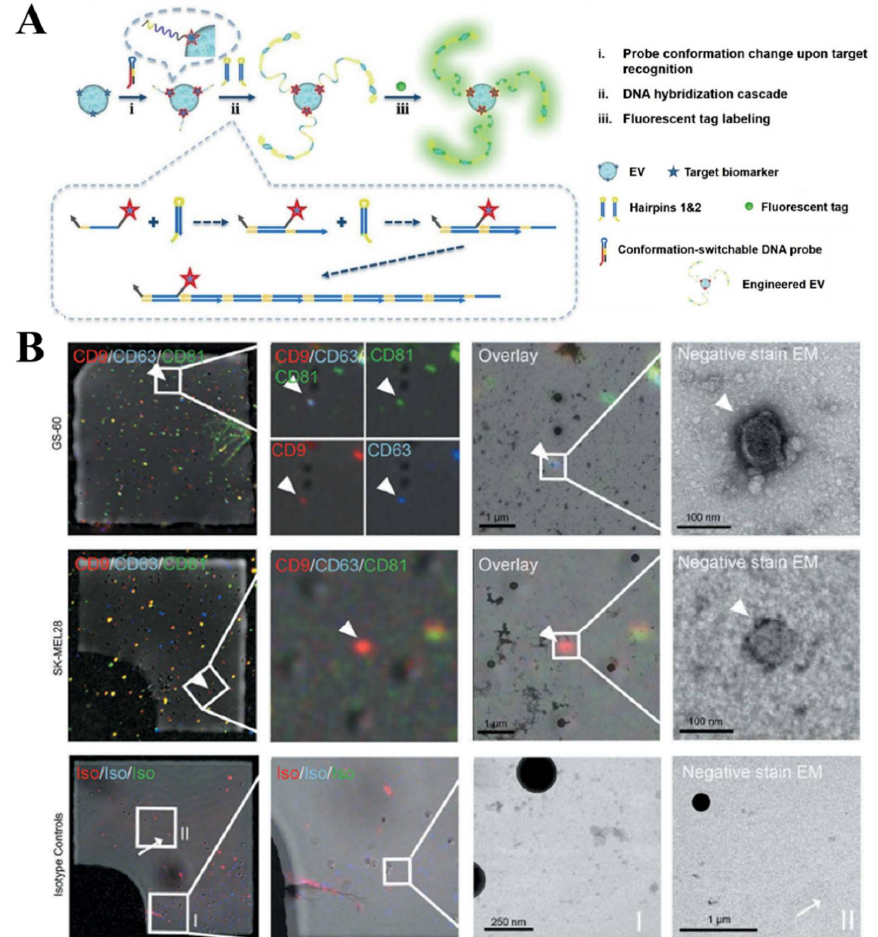
Figure 5. Flow cytometry-based techniques for the single EV molecular analysis. ( A ) Single EV anal- ysis using FCA, achieved by the target-initiated engineering of the DNA nanostructures. Reprinted with permission from [32]. Copyright 2018, Wiley-VCH Verlag GmbH & Co. KGaA, Weinheim. ( B ) Representative IFCM for the tetraspanin profiles on different EVs. White arrowheads indicate fluo- rescence positive single EVs and mark an example of a triple positive EV (GS-60) as well as an ex- ample of a single positive EV (SK-MEL28). White arrows indicate fluorescence positive events that do not appear as EV-like structures in TEM. Reprinted with permission from [61]. Copyright 2019, Taylor & Francis Group.